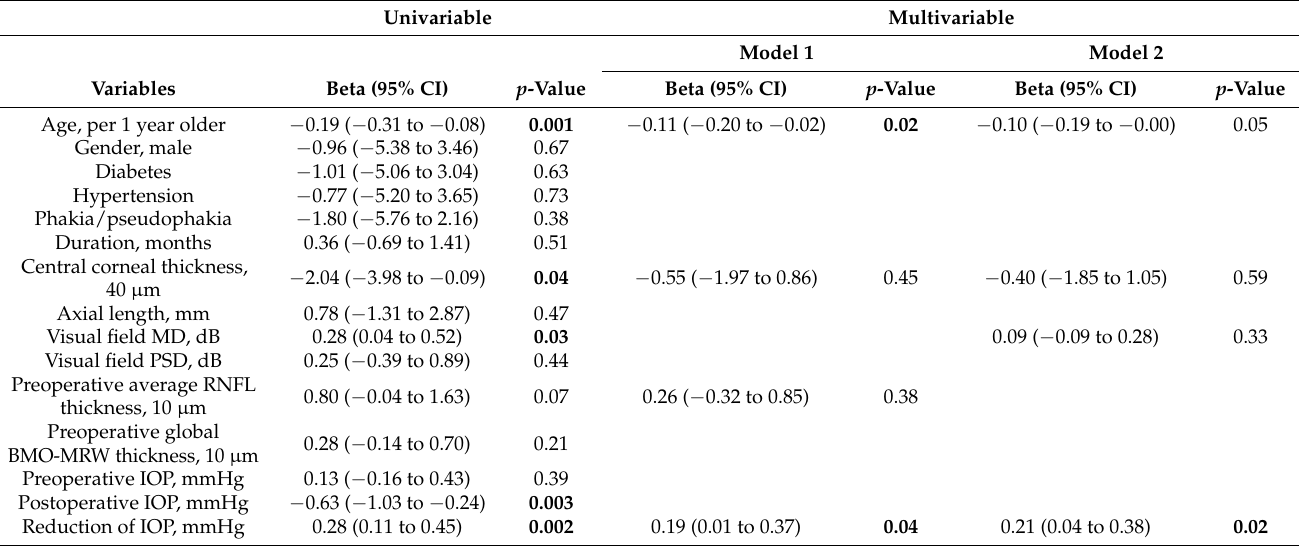
Table 3. Factors associated with an increase in the global BMO-MRW (per 10 µ m) after